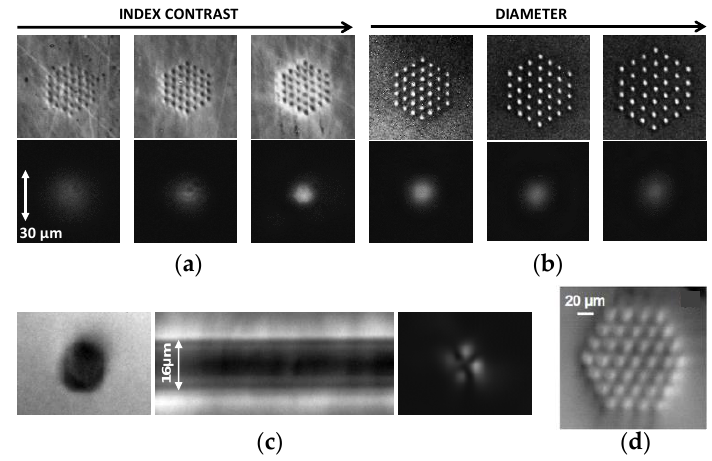
Figure 3. Multicore waveguiding results in Ge 15 As 15 S 70 glass for ultrashort pulse irradiation; ( a ) Mul- ticore cross-sectional profiles in PCM with increasing index contrast and respective guiding behavior at 800 nm. Visible mode confinement appears for higher index contrast. The transverse size is constant and equal to 30 µm; ( b ) Multicore cross-sectional profiles in PCM with increasing inter-trace spacing and corresponding mode behavior at 800 nm injection. In this case the index contrast is kept constant and the transverse dimensions from the left to the right are respectively 36, 42, and 48 µm; ( c ) Continuous large section structure obtained by overlapping traces in cross-section and in a side-view PCM perspective. A higher 800 nm mode LP 21 is obtained; ( d ) Large section (100 µm) multicore (white light illumination) waveguide obtained with individual slit-shaped traces. Details about the experimental conditions are given in ref. [9].